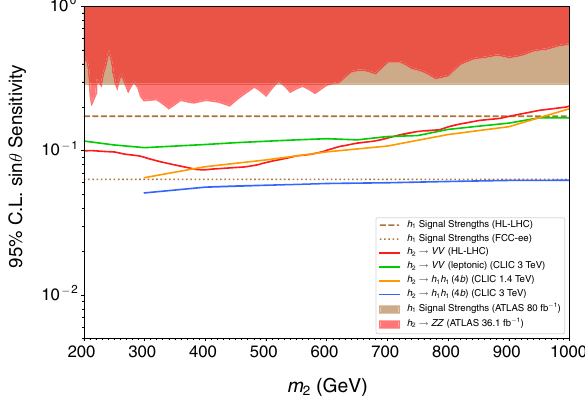
Fig. 14 95% C.L. bounds in the ( m 2 , sin θ ) from current LHC (ATLAS, 80fb − 1 ) Higgs signal strength measurements [51] (brown region), and h 2 → V V searches [19] (red region), together with future HL-LHC (dashed brown) and FCC-ee(dotted brown) sensitivity from Higgssignalstrengthmeasurements,aswellas1.4and3TeVCLIC95% C.L. sensitivities from h 2 → h 1 h 1 ( 4 b ) , as well as HL-LHC and 3 TeV CLIC sensitivities from h 2 → V V , shown respectively as orange, blue, redandgreenlines.AlldirectsearchesassumeBR ( h 2 → h 1 h 1 ) = 0 . 25